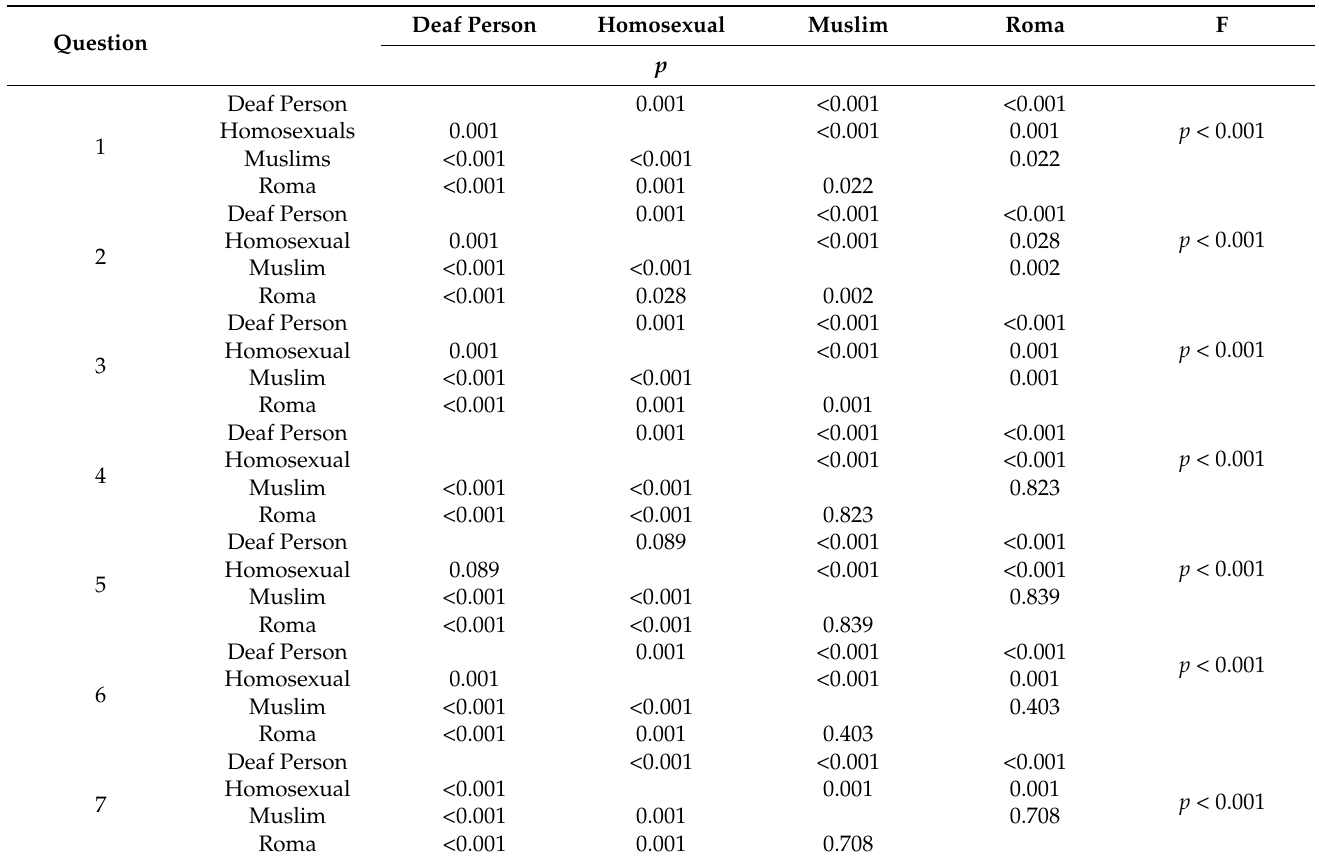
Table 6. Summary of interaction effects between groups in each